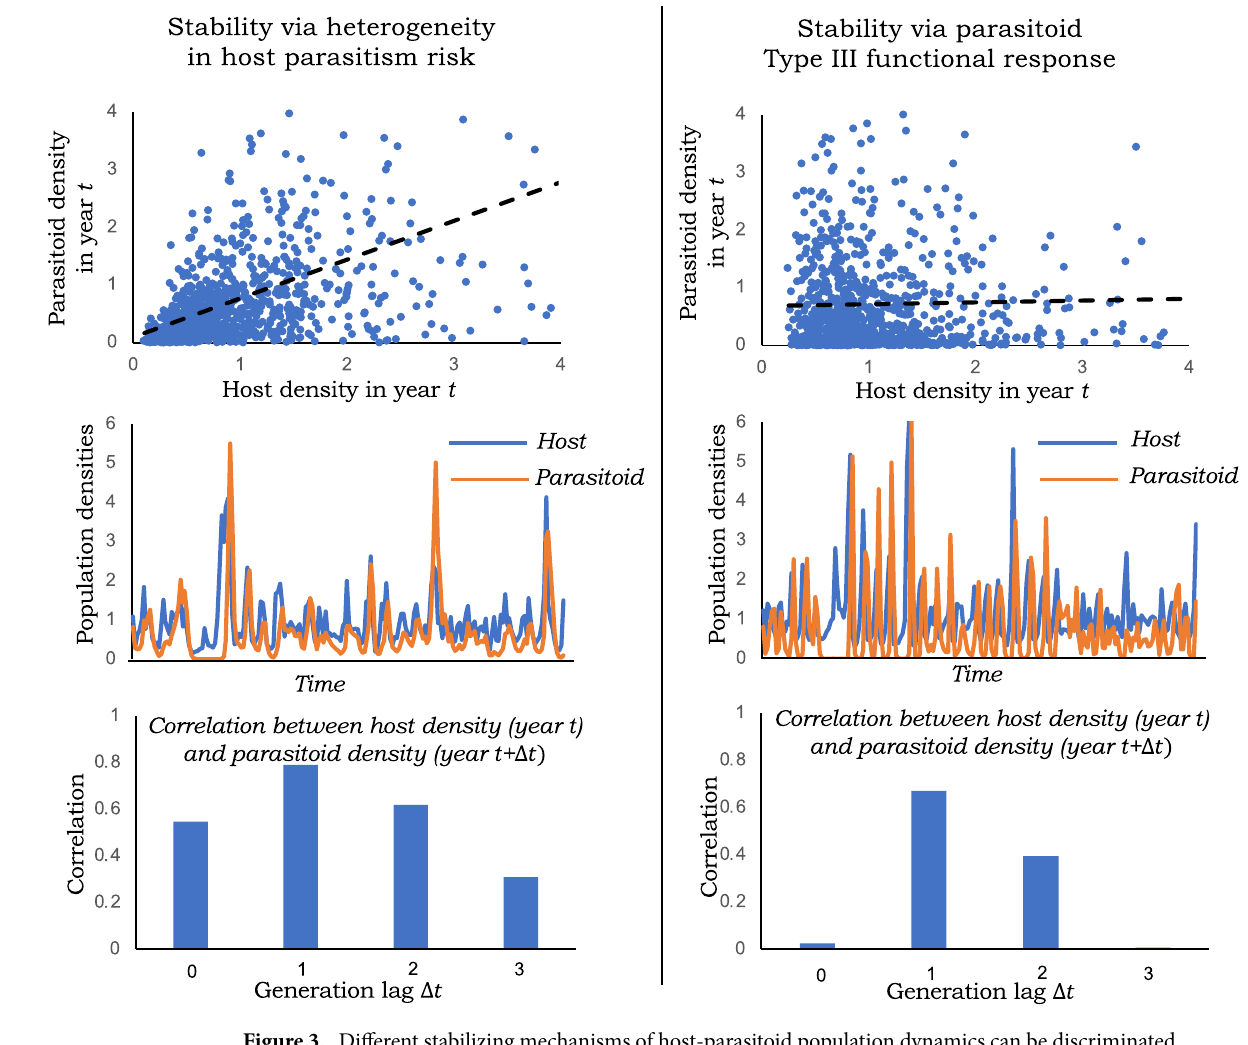
(3)-(4) for CV = 2 , ¯ c = 1 , R = 2 , σ 2 R = 1 along with the time-series of host/parasitoid population densities.